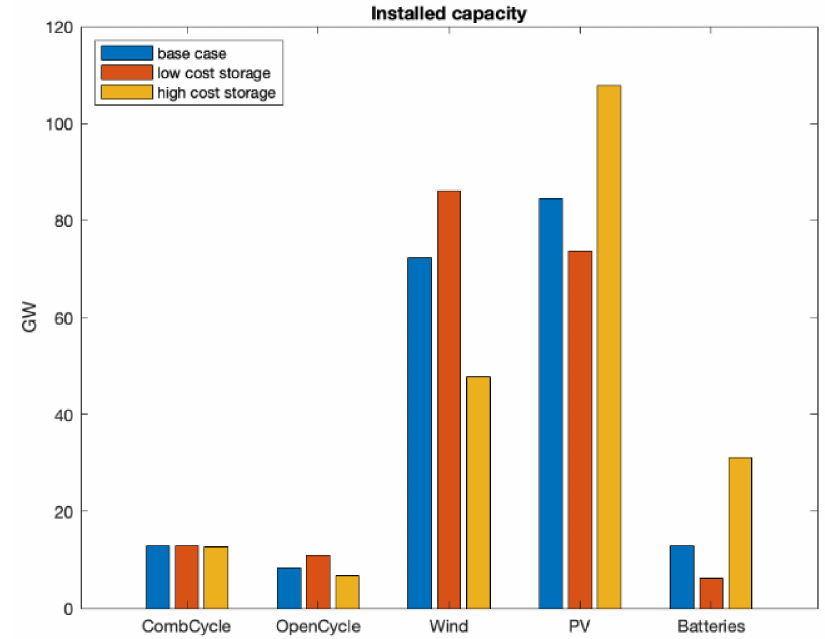
Figure 2. Optimization results. Installed